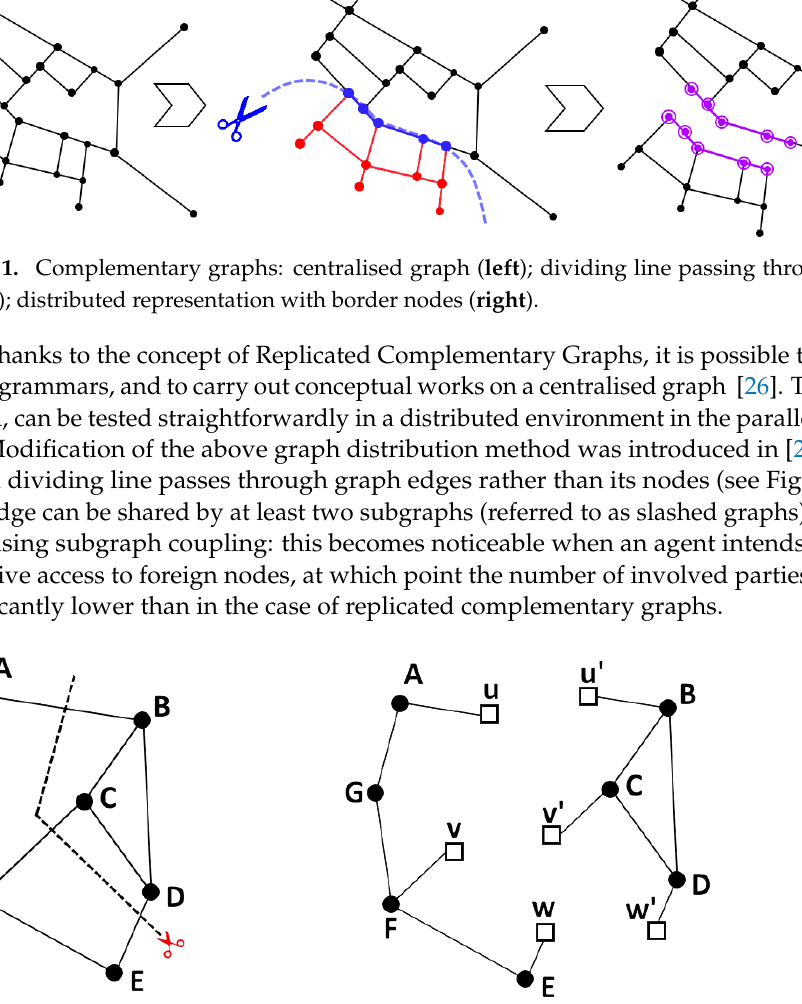
Figure 2. Slashed graphs: centralized graph with dividing line ( left ), and its distributed representation ( right